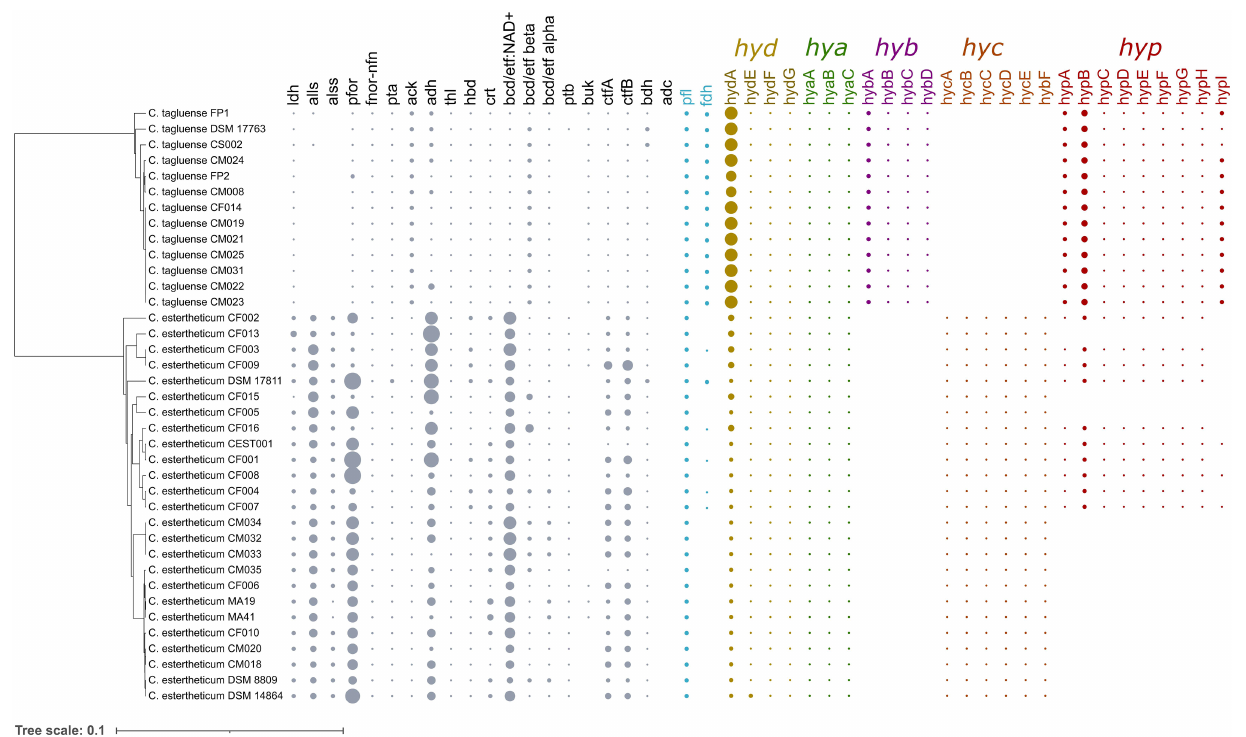
FIGURE 7 | Distribution of acetone–butyrate–ethanol fermentation pathway and hydrogenases genes within C. estertheticum and C. tagluense . The five hydrogenase gene clusters, hyd , hya , hyb , hyc , and hyp are highlighted in different colors. The size of each circle corresponds with the frequency of the gene. A blank shows the gene is absent. The phylogeny is based on the rpoB gene. ldh , L-lactate dehydrogenase; alls and alss , acetolactate synthase large and small subunits; pfor , NADP + pyruvate ferrodoxin oxidoreductase ( fnor-nfn ); pta , phosphate acetyltransferase; ack , acetate kinase; adh , alcohol dehydrogenase; thl , thiolase; hbd , hydroxybutyryl-coA dehydrogenase; crt , crotonase; bcd/etfAB , butyryl-CoA dehydrogenase/electron transfer flavoprotein NAD + ferredoxin, subunits alpha and beta; ptb , phosphotransbutyrylase; buk , butyrate kinase; ctfA/B , coA-transferase subunits A/B; bdh , butanol dehydrogenase; adc , acetone dehydrogenase; pfl , pyruvate formate lyase; and hyd , hya , hyb , hyc , and hyp , hydrogenase gene